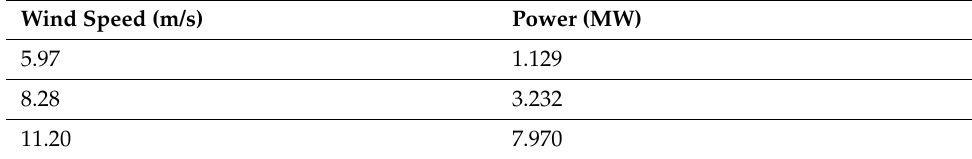
Table 4. Values of Power according to wind